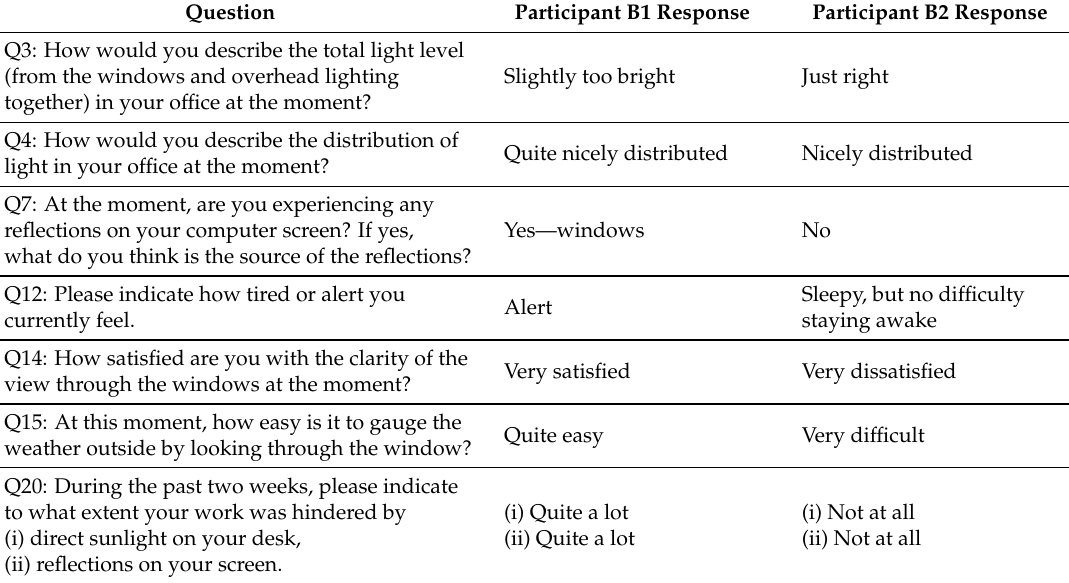
Table 3. Questionnaire responses from Participants B1 and B2 for the example day (response scales all 5-point bi-polar unless stated otherwise; Q3: too dark–too bright; Q4: poorly distributed–nicely distributed; Q7: yes/no (if yes, identify source); Q12: Karolinska Sleepiness Scale (9-point; 1 = extremely alert, 9 = extremely sleepy); Q14: very dissatisfied–very satisfied; Q15: very difficult–very easy; Q20: not at all–very